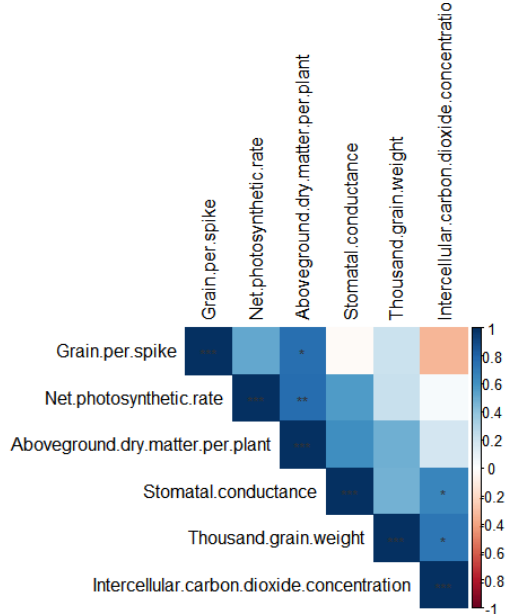
Figure 7. Correlation analysis of different wheat indexes (X axis and Y axis represent different indexes, r values in the Figure in different colors, *: p ≤ 0.05, **: p ≤ 0.01).